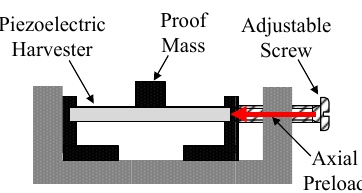
Figure 14. Schematic representation of the axial loads based MTT proposed in [30].